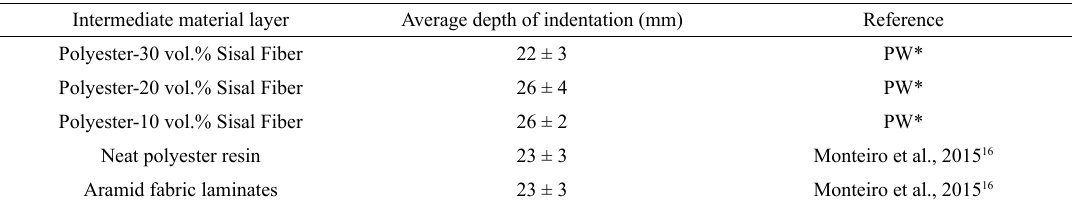
Figure 3. View of the MAS target after the ballistic test, with second layer of (a) neat polyester resin; (b) 10 vol.% sisal fiber polyester composite; (c) 20 vol.% sisal fiber polyester composite; (d) 30 vol.% sisal fiber polyester composite. Table 1. Average depth of indentation in the clay witness backing different multilayered